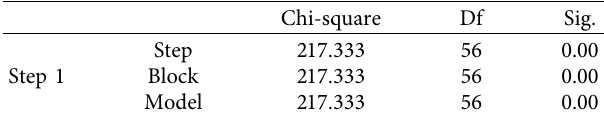
Table 12: The backward stepwise model